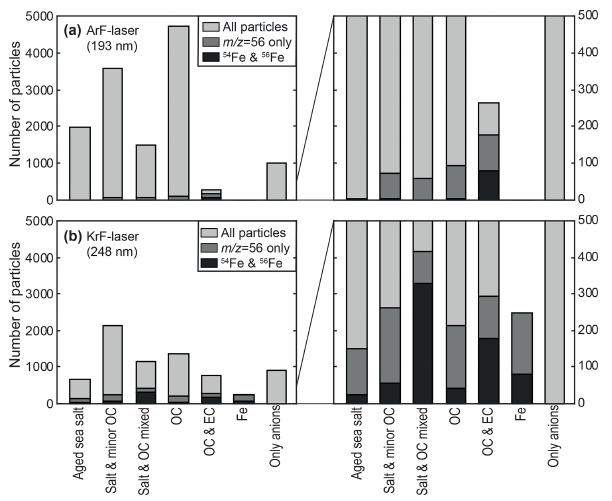
Figure 5. Number of particles within the main classes according to Table 2. Dark grey fractions represent particles with a peak area at m/z = 56 being larger than at m/z = 55 (molecular fragments) and m/z = 40 (Ca + because of interference with 56 CaO + ), indicat- ing Fe content. Black fractions illustrate particles showing an addi- tional signal of the less abundant isotope 54 Fe + . (a) If ionized with 193nm pulses, substantial fragmentation leads to dominating frag- ment signals in many of the 15000 exposed particles. Fe signals are almost exclusively observed for particles with EC signatures (see the enlarged view on the right), indicating a particularly high Fe content or possible interactions with strongly absorbing soot dur- ing ionization. (b) Although fewer particles produce ion signals if exposed to 248nm pulses, the particle fraction showing Fe signa- tures is much larger, and a cluster with dominating Fe signals even appears. It is important to note that the Fe signals are not limited to EC-containing particles but can be observed for all classes. This suggests that the resonant ionization allows a more universal and secure detection of